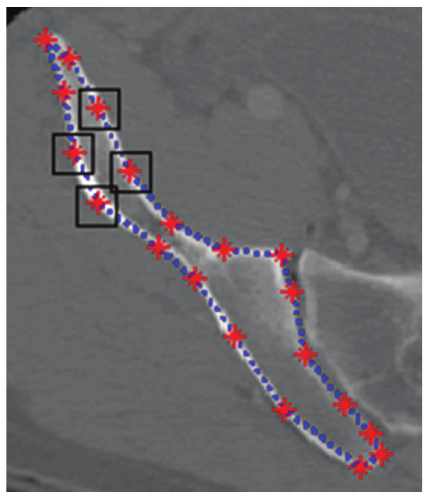
Figure 4: Example windows around the boundary of pelvic bone, positioned according to